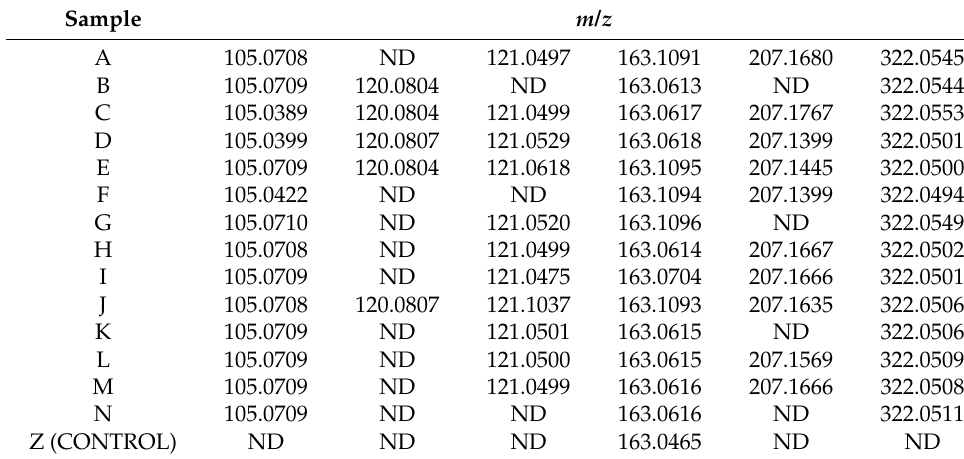
Table 2. DSA-TOF-MS signals for analyzed honeys. ND: Not